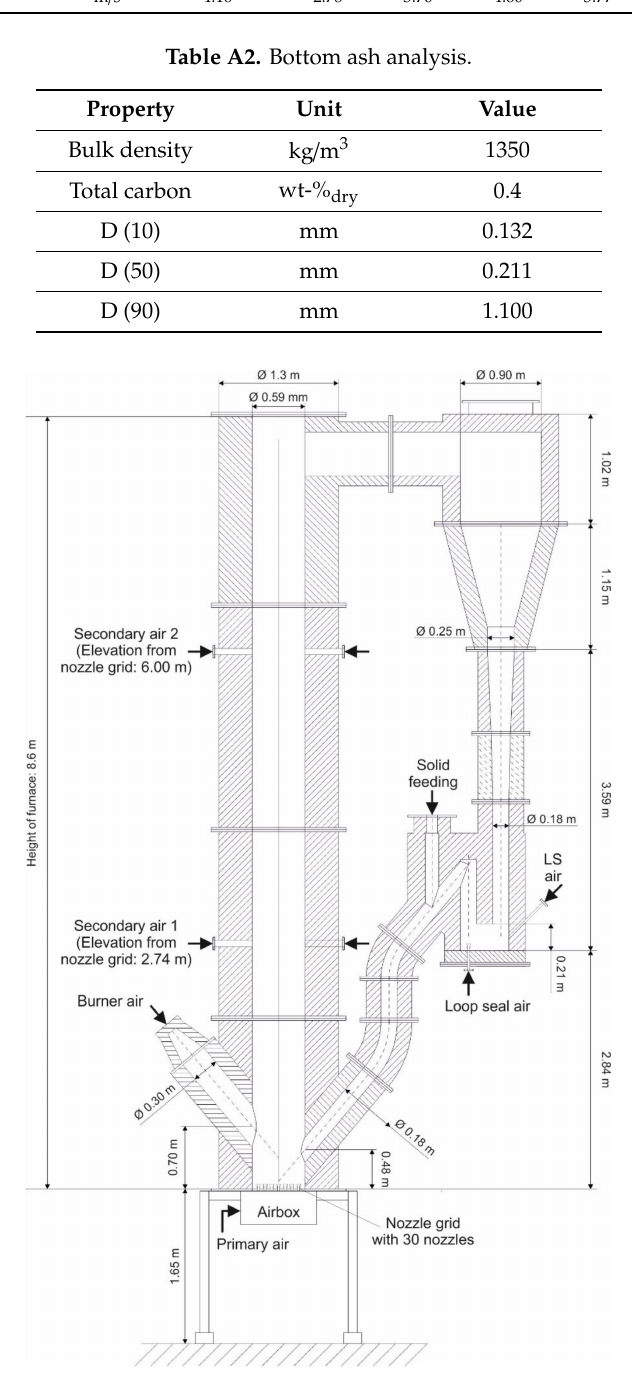
Figure A1. Detailed geometry of CFB